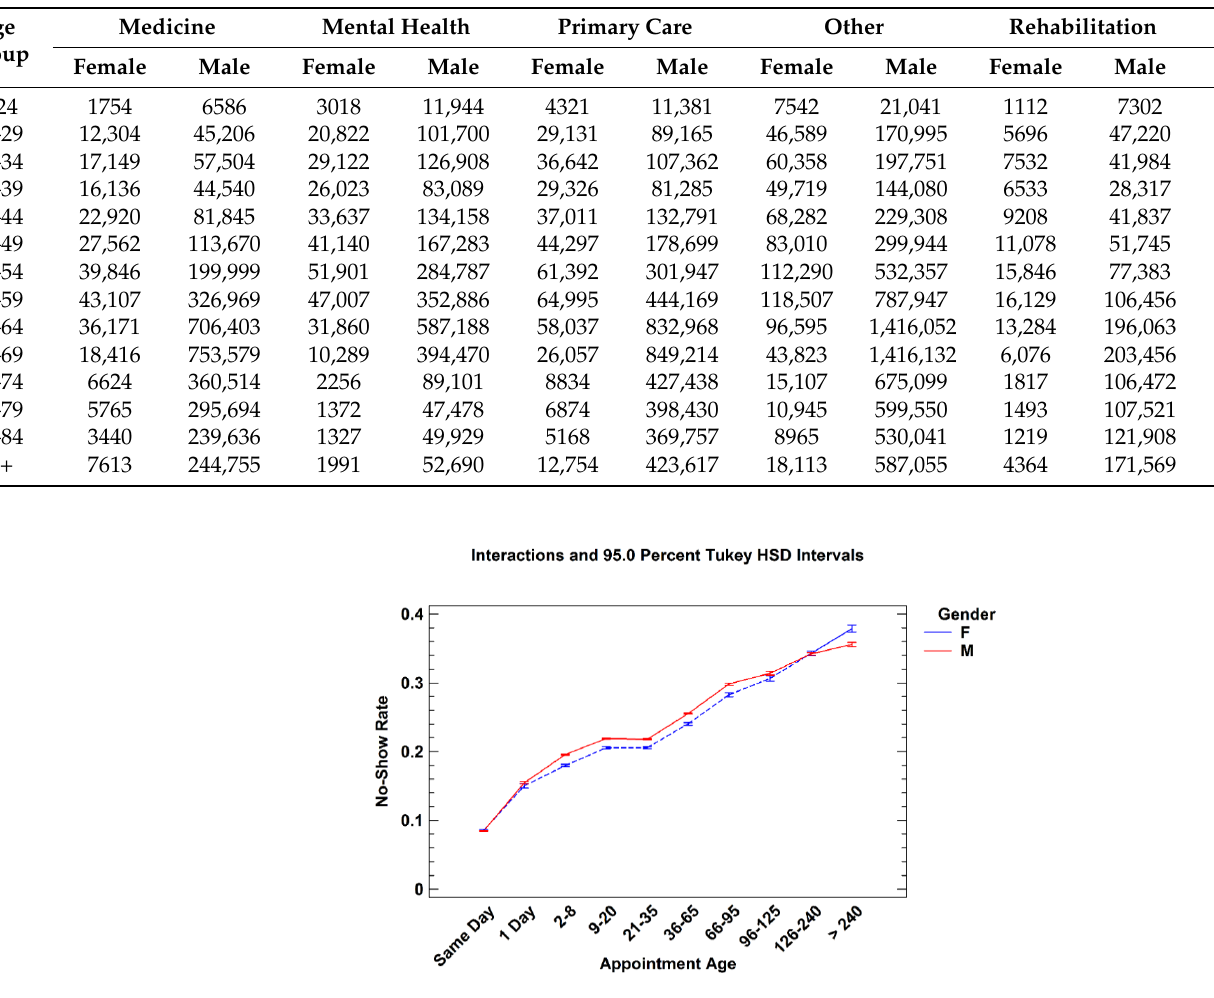
Figure 4. No-show rates for males and females by appointment age groups.